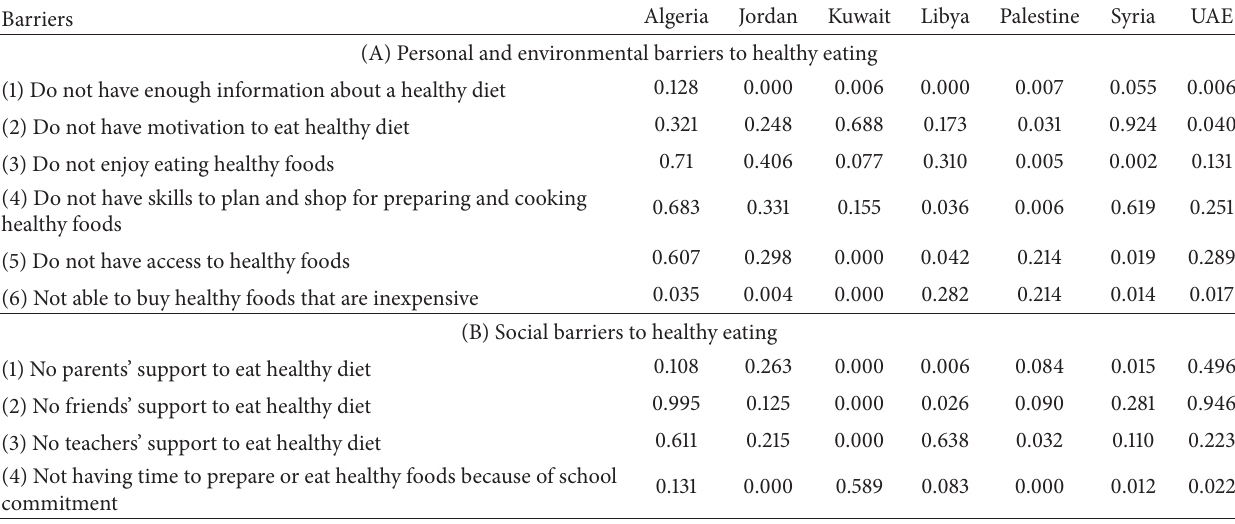
Table 7: Significant differences ( P value) between males and females for perceived barriers to healthy eating among Arab adolescents (using chi-square